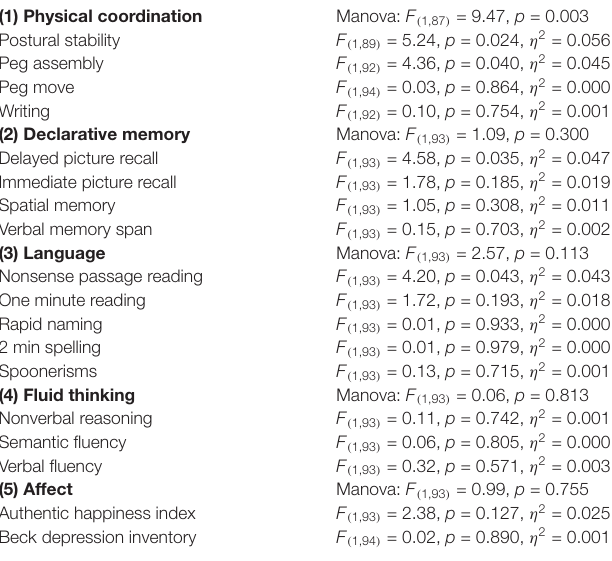
TABLE 1 | Multivariate and univariate analyses of variance for the variables of interest. (1) Physical